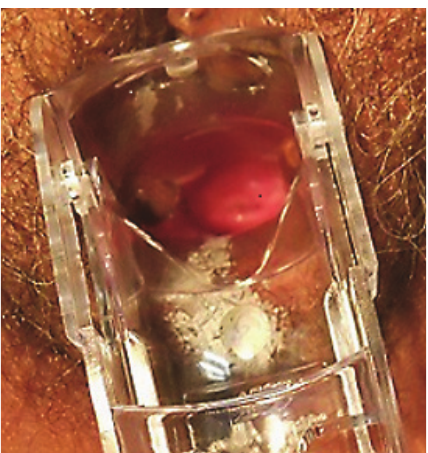
Figure 3: Photograph of Case 2 , showing what appears to be a cervix in a postmenopausal woman who had undergone a total hysterectomy with bilateral salpingo-oophorectomy.